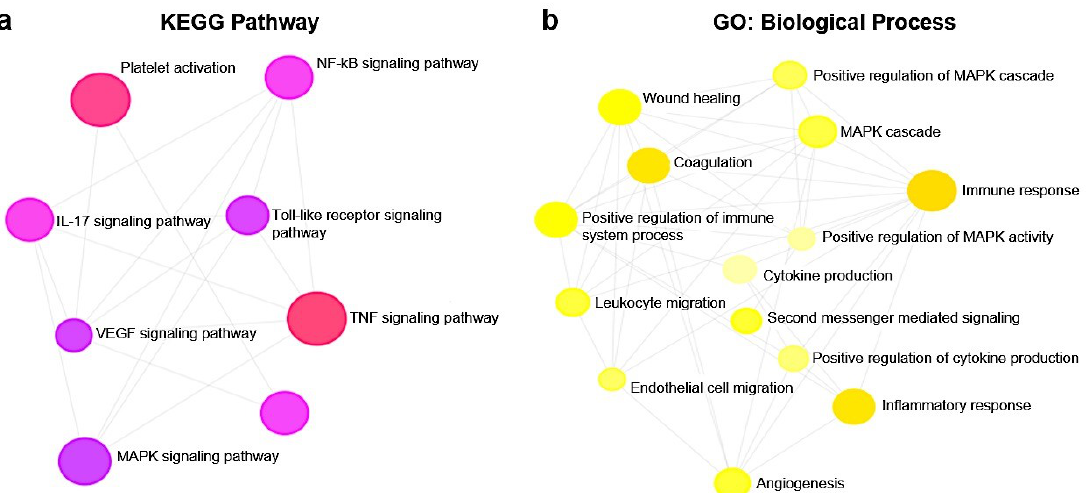
Figure 8. KEGG pathways involved in TNF- α response at vascular level ( a ) and GO (biological processes) ( b ) analyses were performed on 29 genes di ff erentially expressed in EA.hy926 cells treated with TNF- α (20 ng / mL) alone and pretreated with B-ELNs (20 µ g / mL) and then exposed to TNF- α (20 ng /